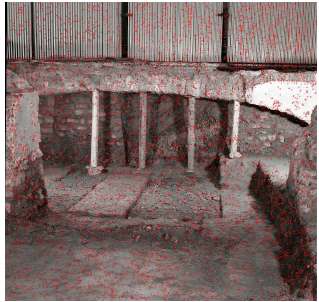
Figure 7 . Feature Point selection during the photogrammetric workflow applied to historical images.